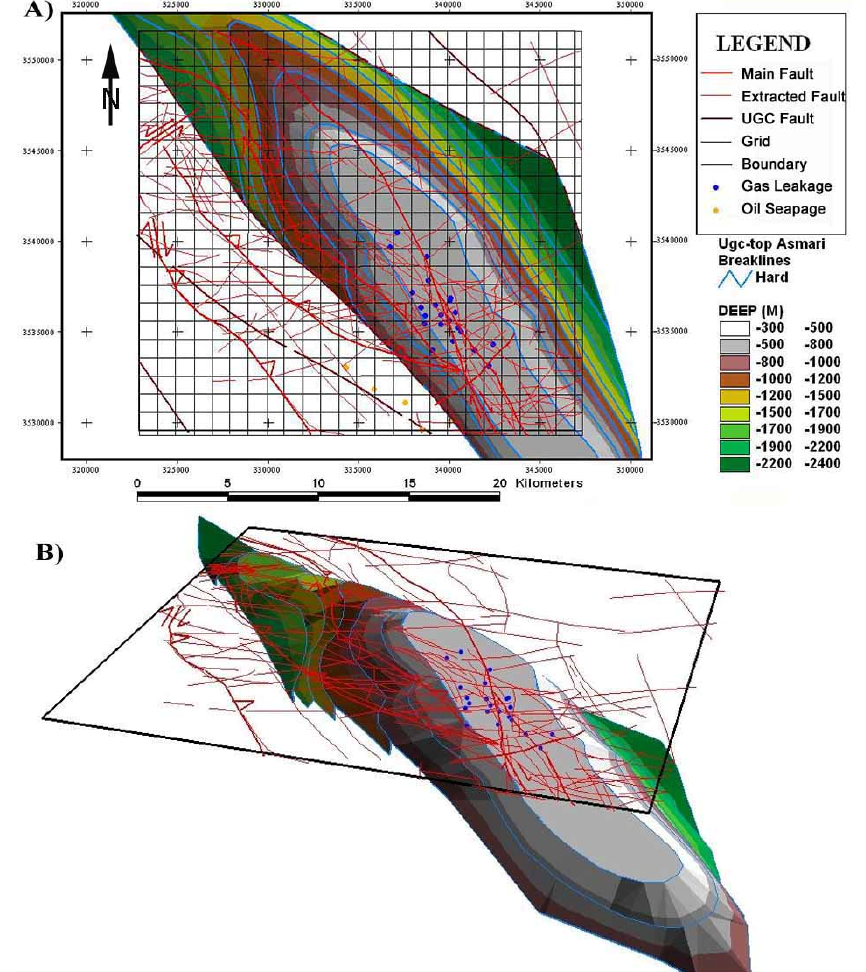
Figure 4. Showing the 3D model of structures-gas leakages relationship (a) Preparation of Iso-potential surface of UGC map and overlaying surface structures [10] (b) Construction of 3D-sketch from iso-potential surface and its